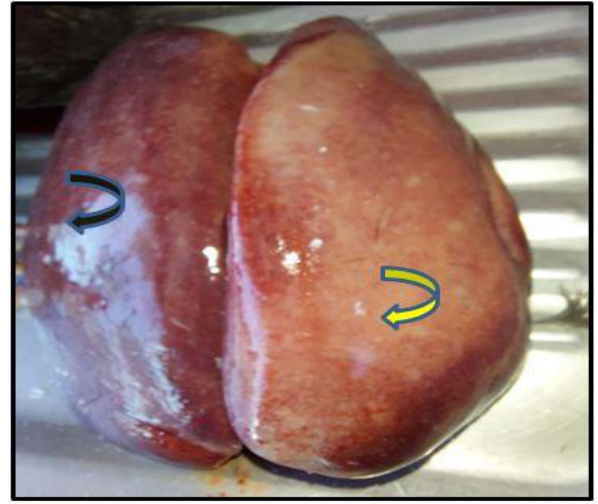
Fig.2: chicken liver showed sever paleness (yellow arrow) in addition to patches of hemorrhage (Blake arrow).